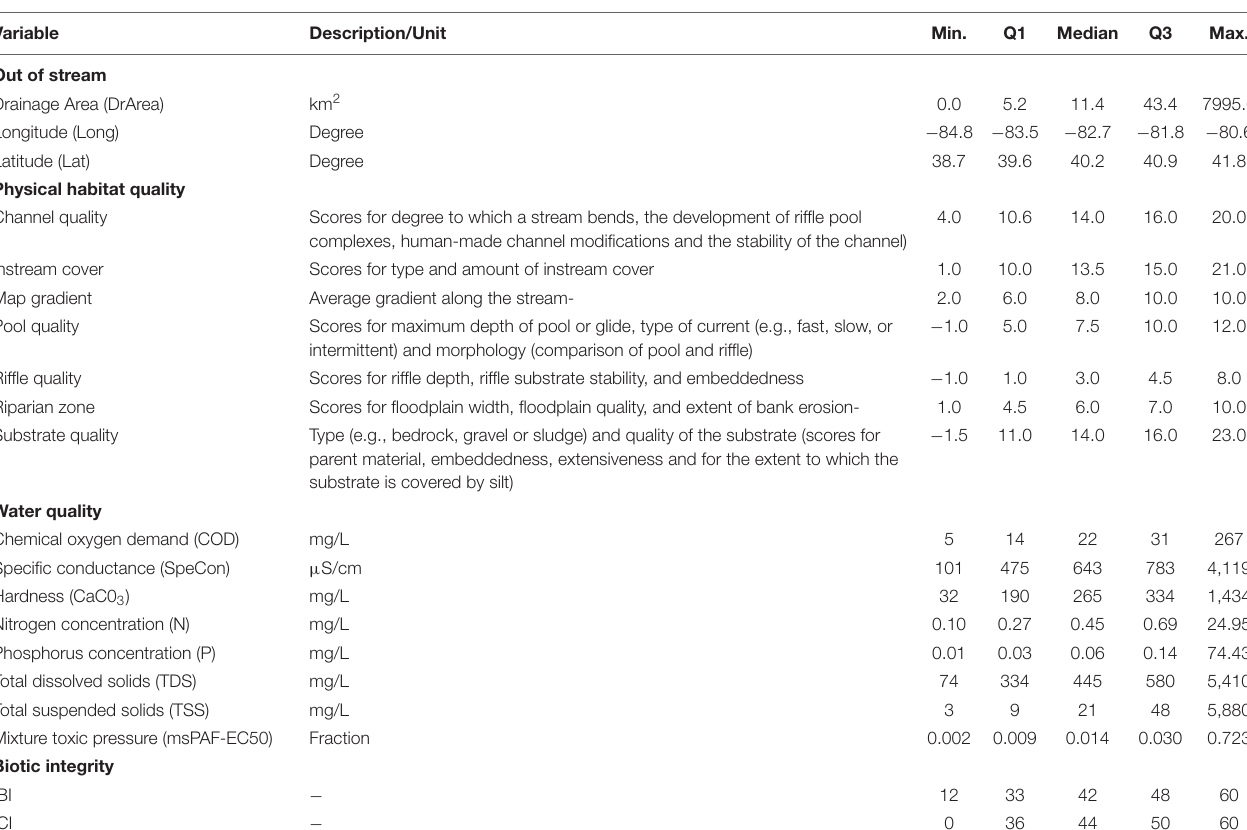
TABLE 2 | Variables included in our